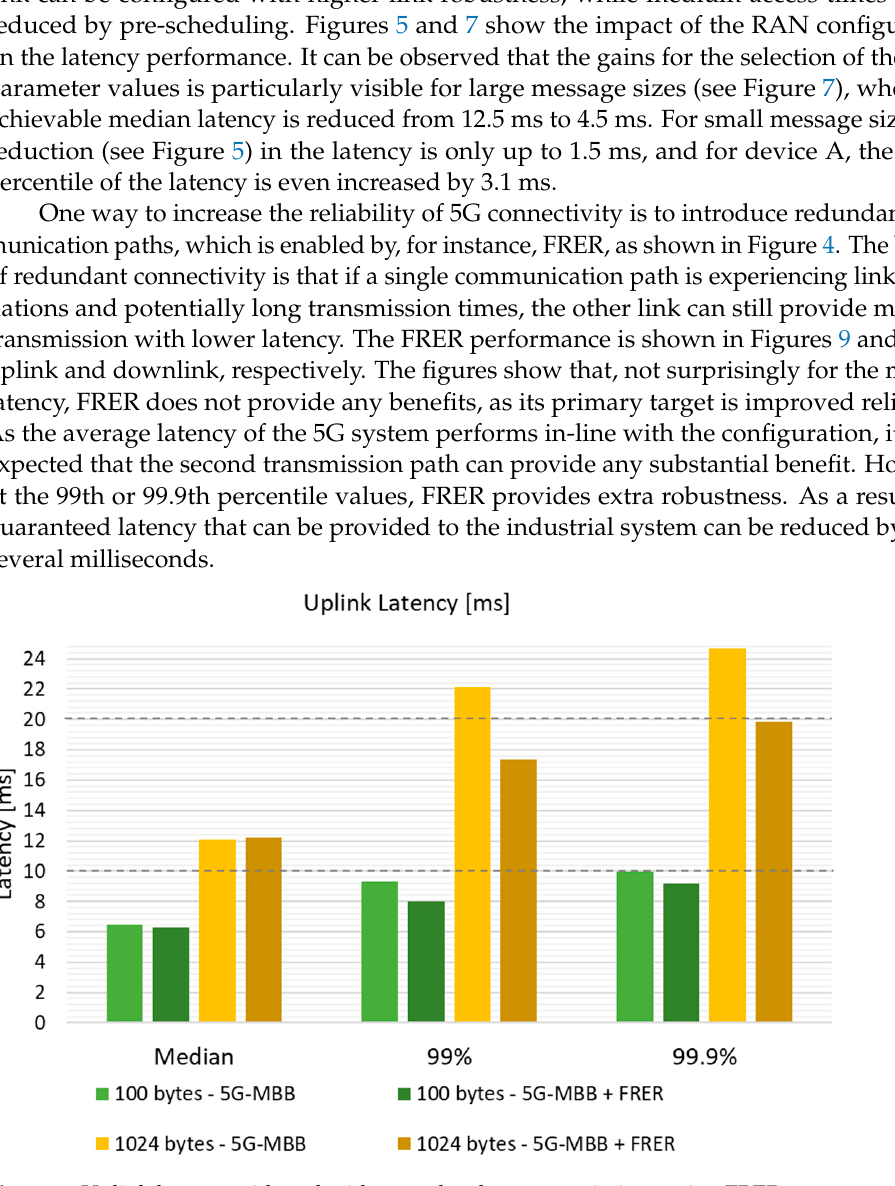
Figure 10. Downlink latency with and without redundant transmissions using FRER. For 5G, many features have been standardized, and these features allow ultra-low latency and high reliability to be achieved in stringent industrial IoT use cases as needed. We have conducted experiments with the URLLC testbed system described in Section III, in which several of the 3GPP Rel. 15 and Rel. 16 standardized URLLC features were implemented in the network and the device. The results in in Figures 5–8 . show that with the proper design and usage of standardized 5G URLLC functionality, much lower latencies are able to be achieved and can also be guaranteed with high reliabilities in comparison to MBB-focused 5G systems. For small and large messages, the median latencies are below 0.8ms in uplink and between 0.8–0.9 ms in downlink. Even for guaranteed latencies at 99.9th percentile, the latencies remain below 1.09–1.12 ms. A FRER configuration with redundant traffic flows over the URLLC testbed was not considered, as it is not expected to reduce latency below the already low latency bounds. While the presented results on the commercial 5G eMBB system in this article focuses on the 5G- SMART use cases (cf. [11]), we carried out the latency performance evaluation in both the UL and DL directions on the URLLC testbed for a wide range of packet sizes ranging from 100 bytes to 1500 bytes. Our empirical results indicate that the URLLC features guarantee a latency bound of approximately 1 ms for both the UL and DL directions for these packet sizes up to 99.9th percentile value.